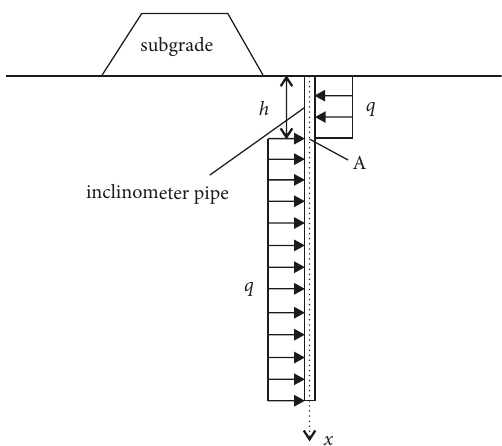
Figure 2: Stress analysis of the